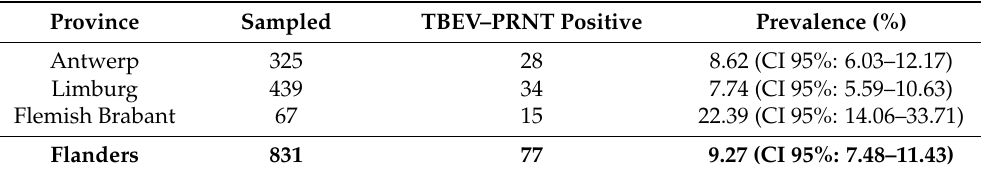
Figure 4. TBEV seroprevalence in wild boar sera per province. The hunting spots are indicated by green dots. The pie chart depicts the percentage of positive and negative samples per province. Tick collection sites are indicated with a red star. Table 2. The prevalence of tick-borne encephalitis virus prevalence per province in wild